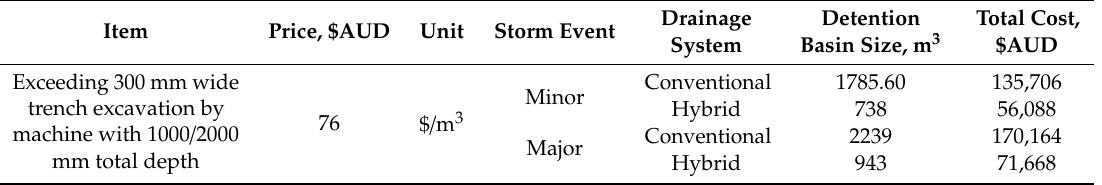
Table 5. Cost of detention basin for both drainage Table 6. Cost of different items of the conventional drainage system (pipe and pit network).